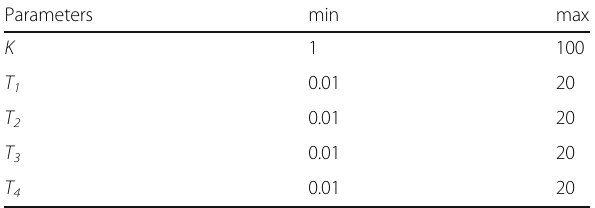
Table 1 Ranges of control parameters to be evolved Parameters